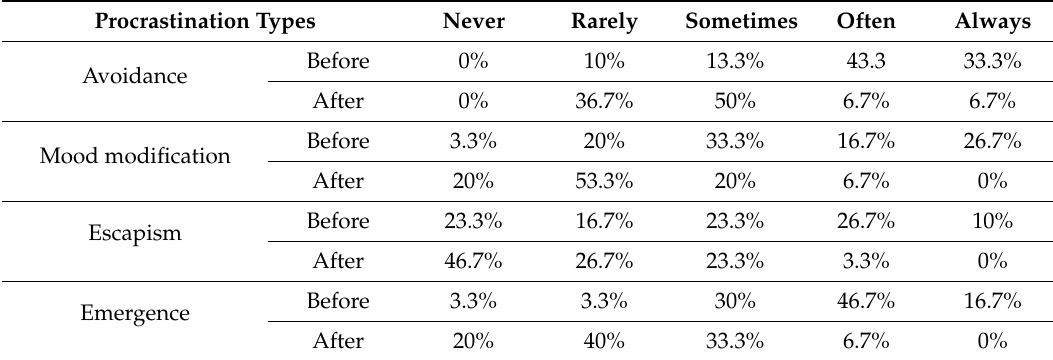
Table 8. Experiencing procrastination in its various types before and after using